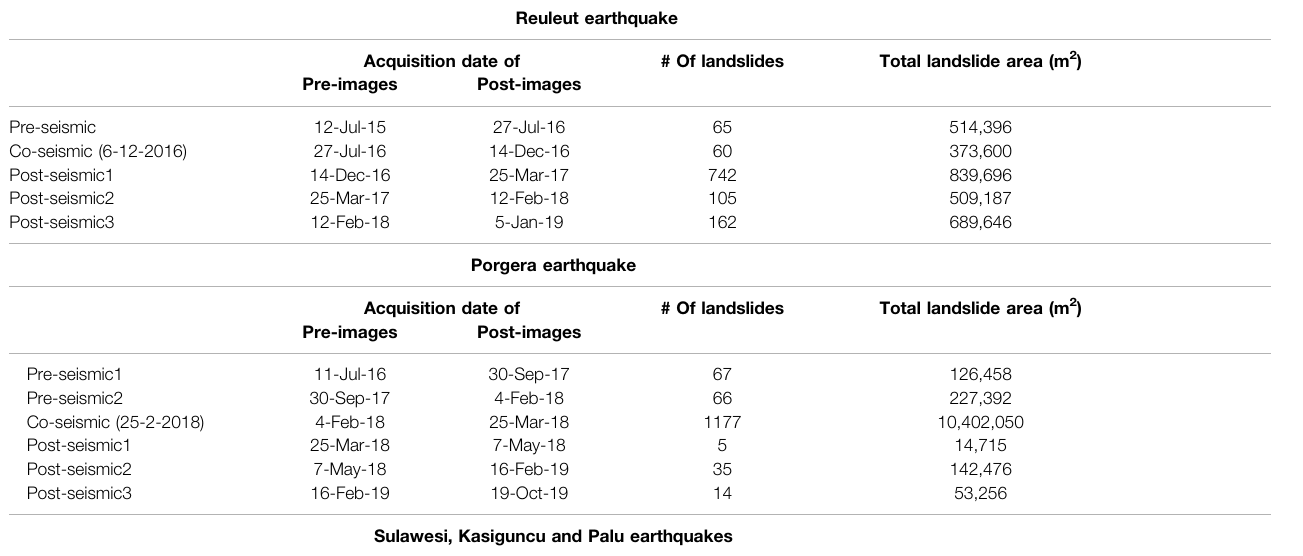
TABLE 1 | Details of the multi-temporal landslide